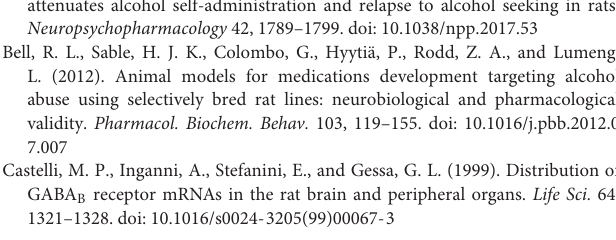
Supplementary Figure 1 | Structure and compound analysis of KK-92A. KK-92A was synthesized in gram-scale with > 99% purity (as determined by